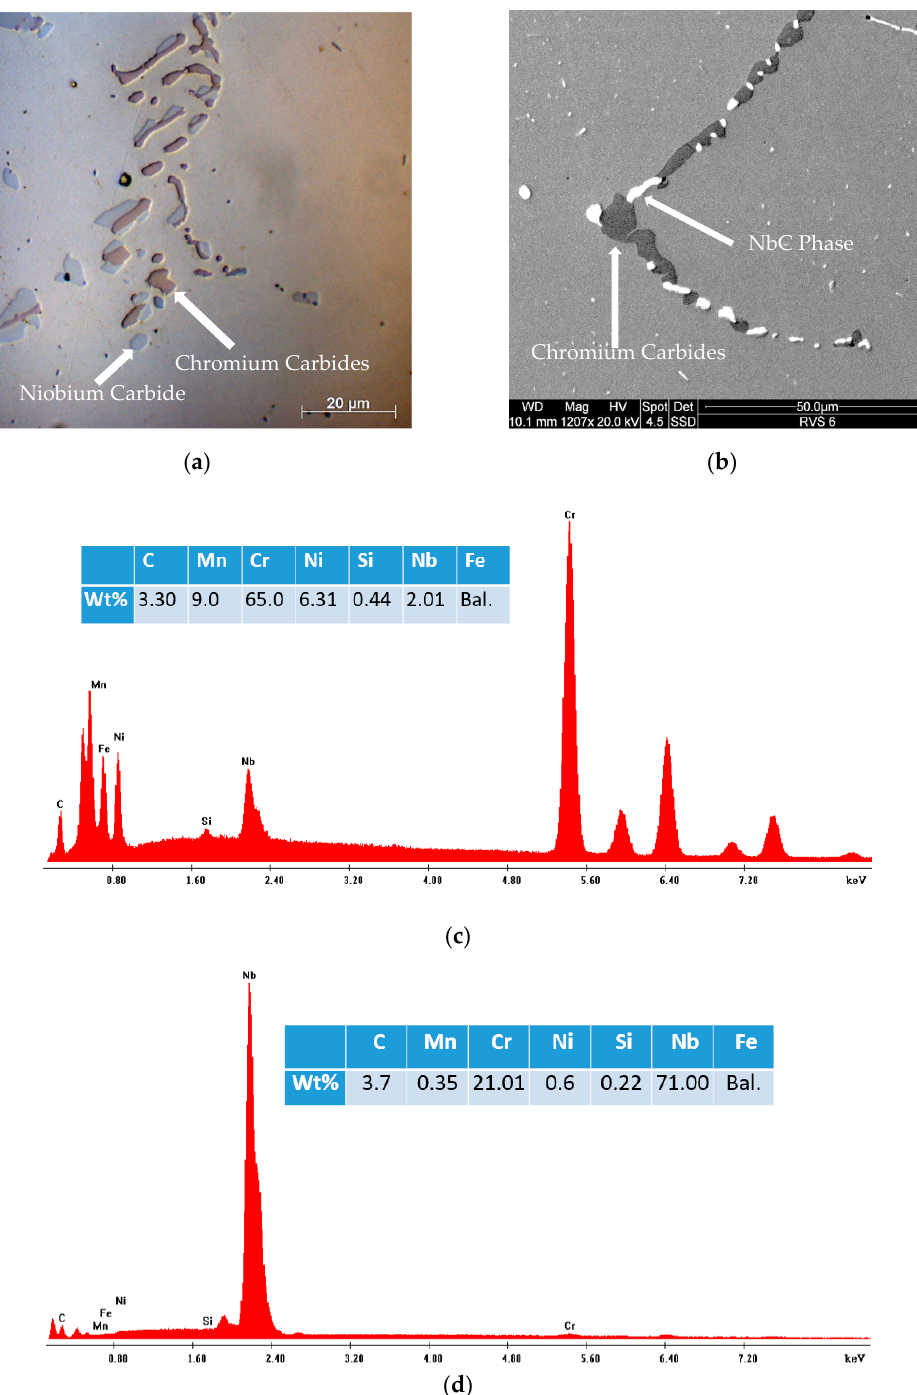
Figure 2. ( a ) Optical and ( b ) SEM images of the microstructure in failed tubes, together with EDS analyses of the ( c ) black phase (chromium carbide) and ( d ) white phase (NbC).